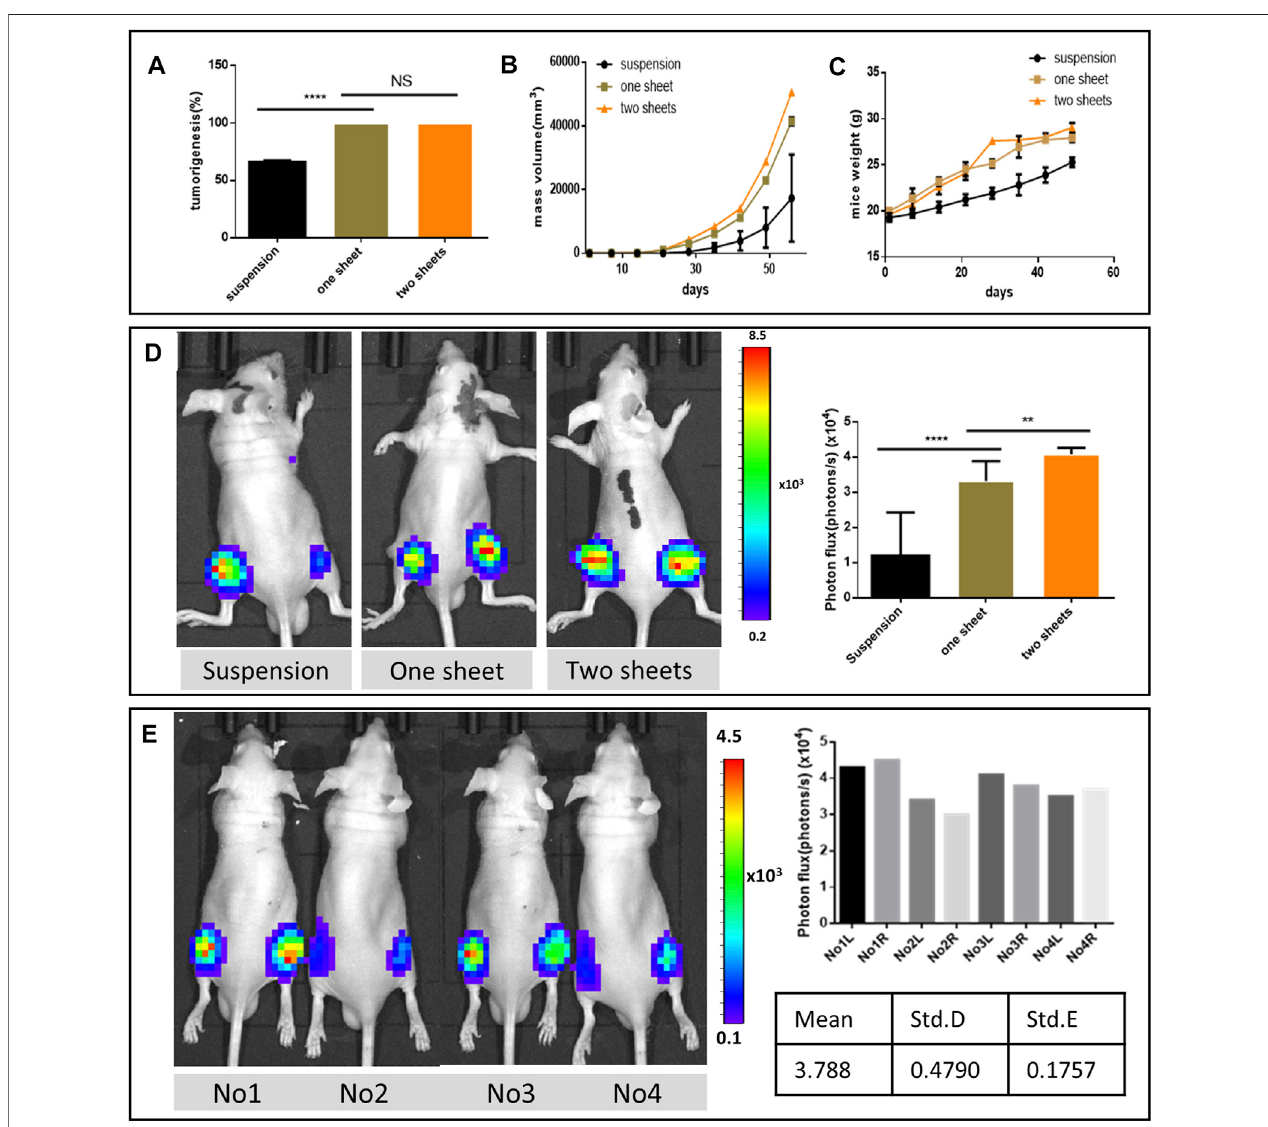
FIGURE 2 | Tumor formation analysis. (A) Comparison of tumorigenesis rate. (B) Mass volume of the formed tumor. (C) Growth weight curve of the tumor formed mice.(n (cid:2) 6, graphdisplaysmean ± SEM). (D) Representative bioluminescentimagesofnudemice fromdifferentgroups 21 days after orthotopic tumor inoculation